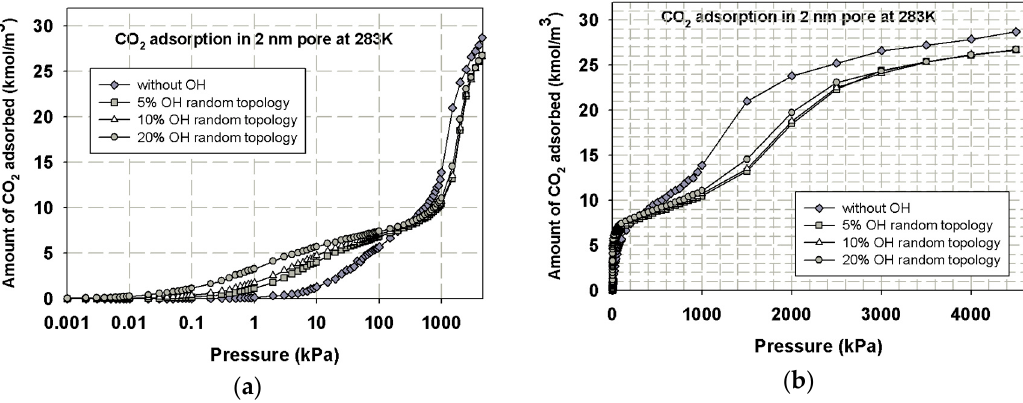
Figure 12. CO 2 adsorption isotherms at 283 K in a slit pore model of porous silica glass with 2 nm. width and di ff erent concentrations of OH ( a ) plotted in semi-log scale and ( b ) plotted in linear scale .